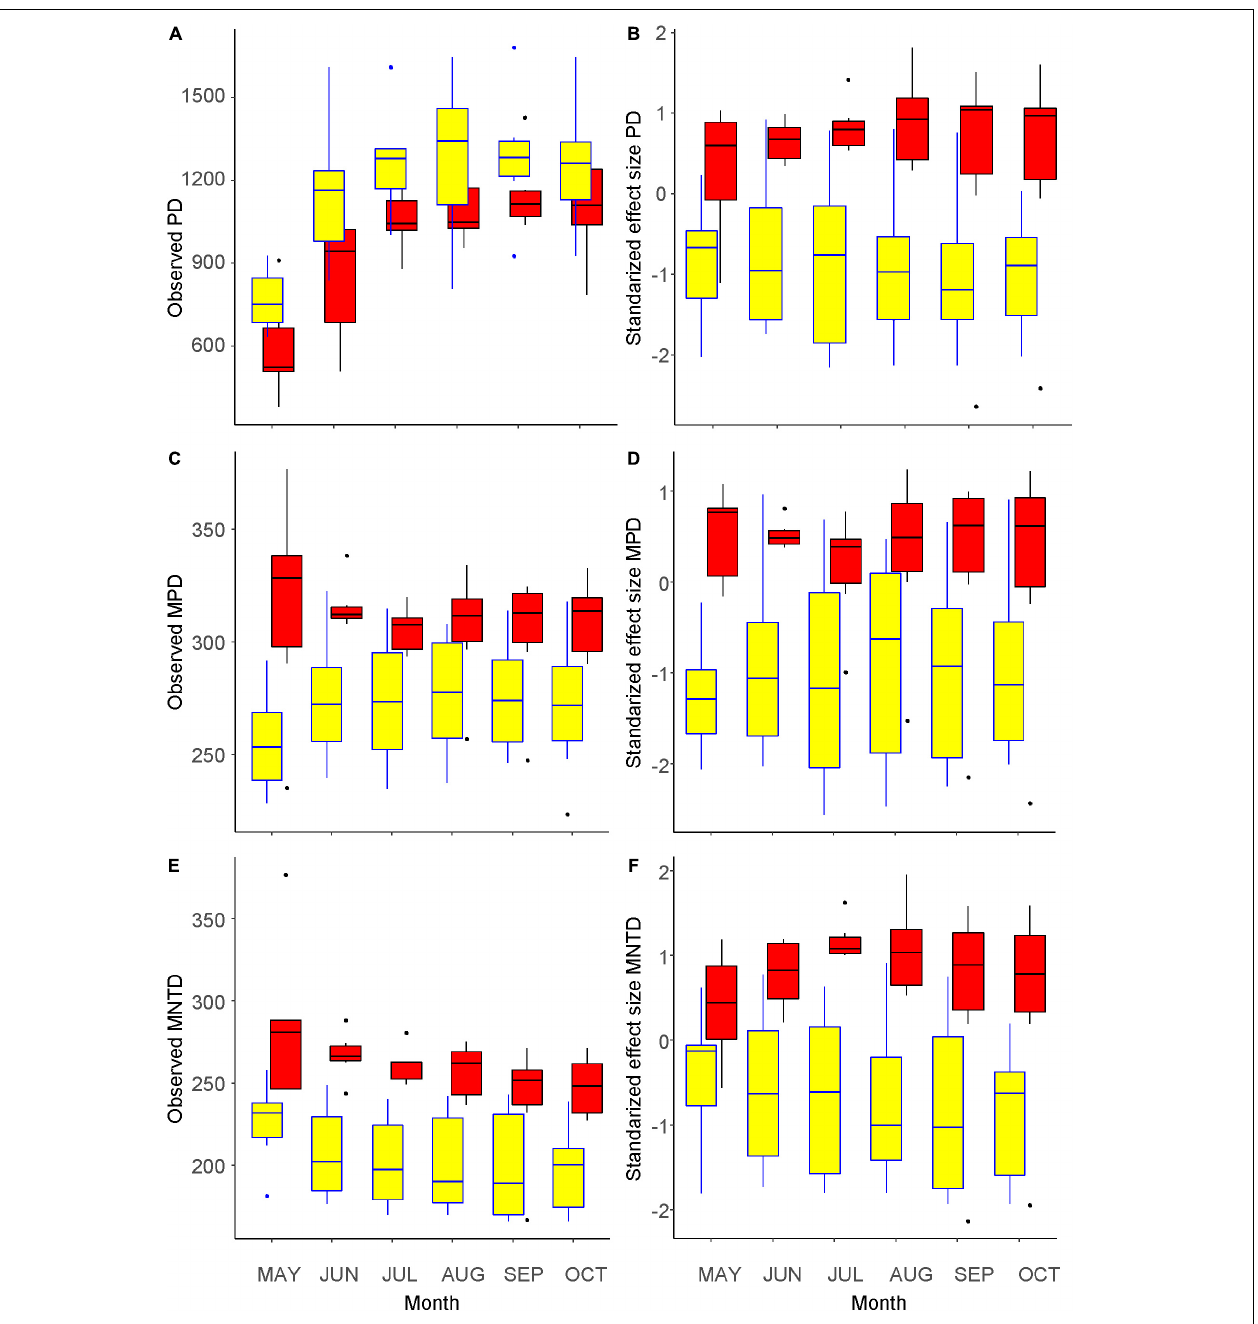
FIGURE 3 | Metrics of phylogenetic diversity of the understory vegetation inside (yellow) and outside (red) of an exclosure fence at a Zelkova serrata plantation in the University of Tokyo Chichibu Forest. (A) Phylogenetic diversity (PD). (B) Standardized effect sizes of phylogenetic diversity (SES.PD). (C) Mean pairwise distance (MPD). (D) Standardized effect sizes of mean pairwise distance (SES.MPD). (E) Mean nearest taxon distance (MNTD). (F) Standardized effect sizes of mean nearest taxon distance